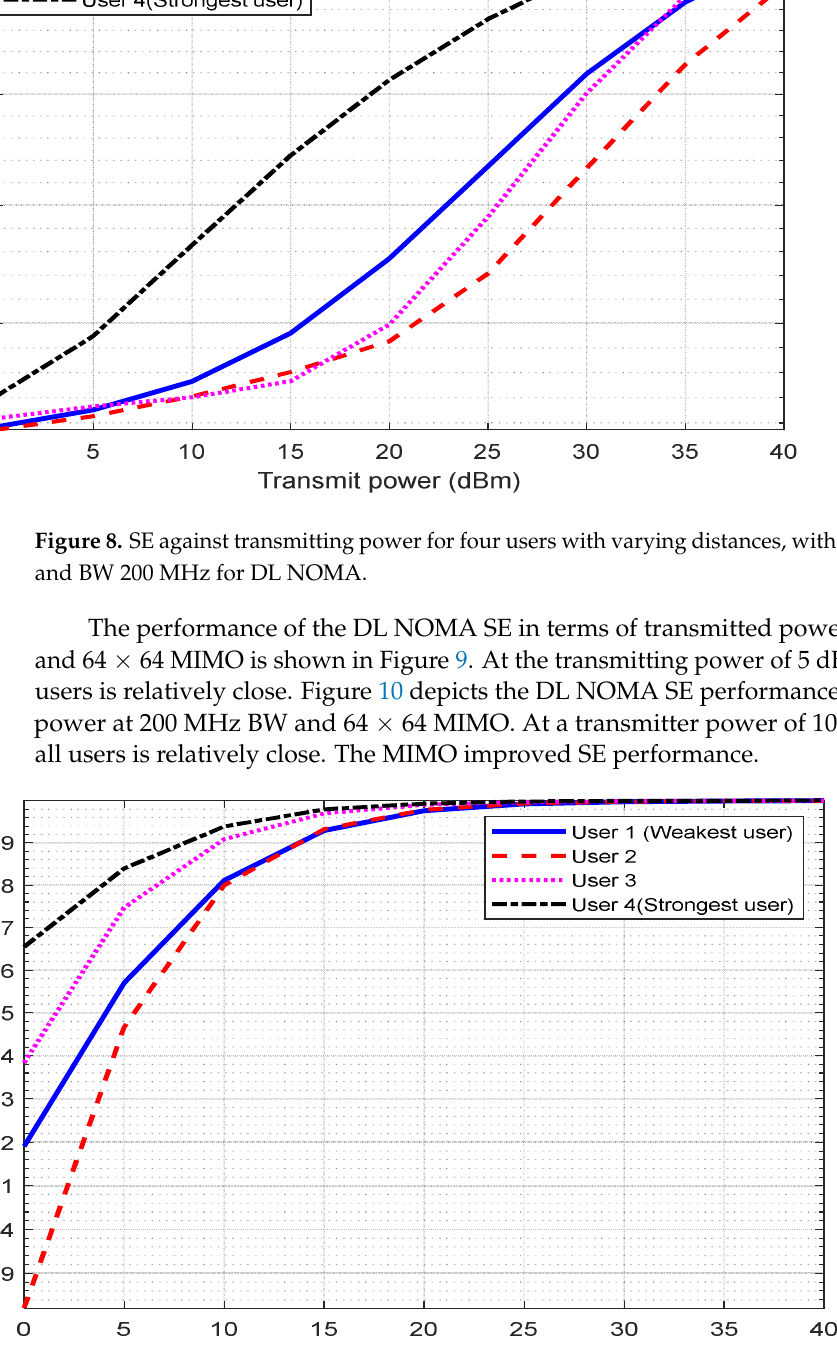
Figure 7. SE vs. transmit power for four users with varying distances, with power coefficients and BW 80 MHz for DL NOMA.